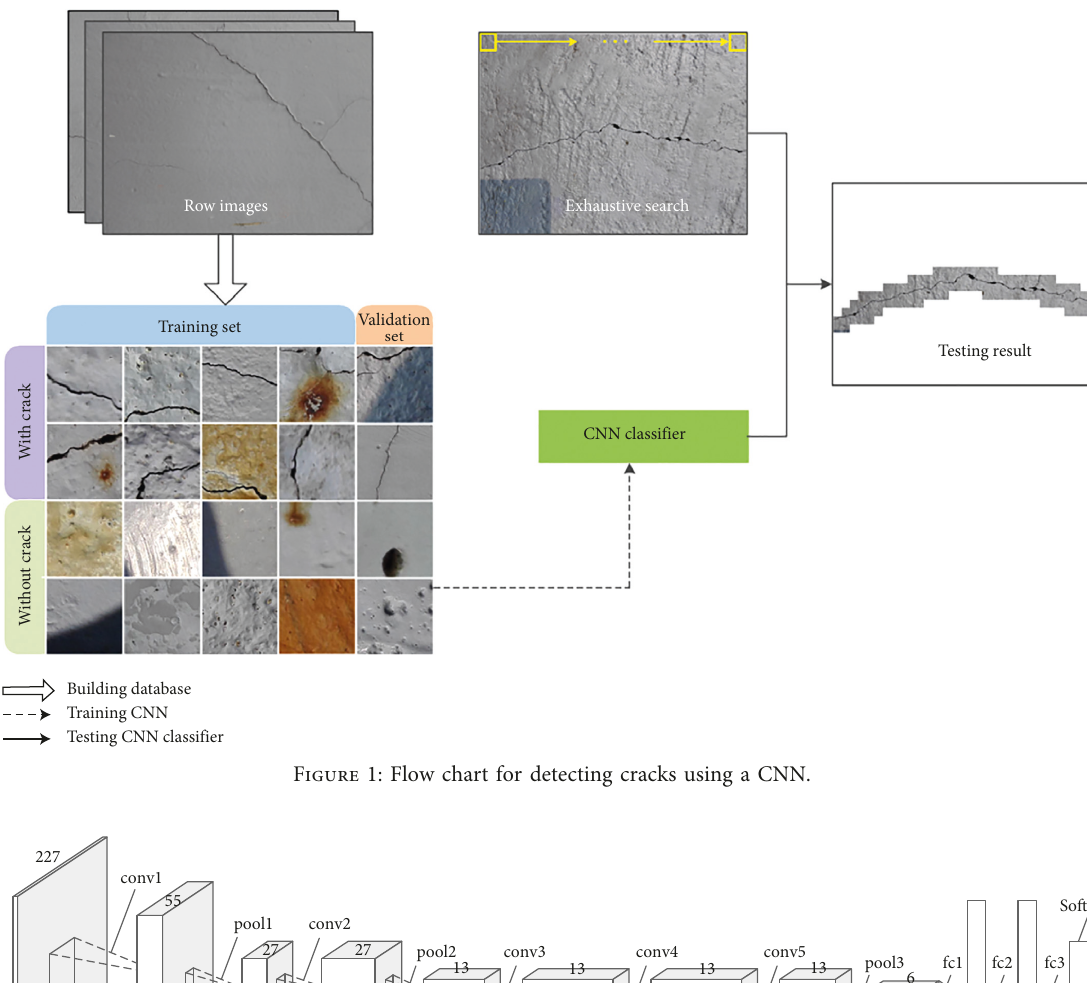
pooling; fc# full connection; k# (cid:31) (cid:31)